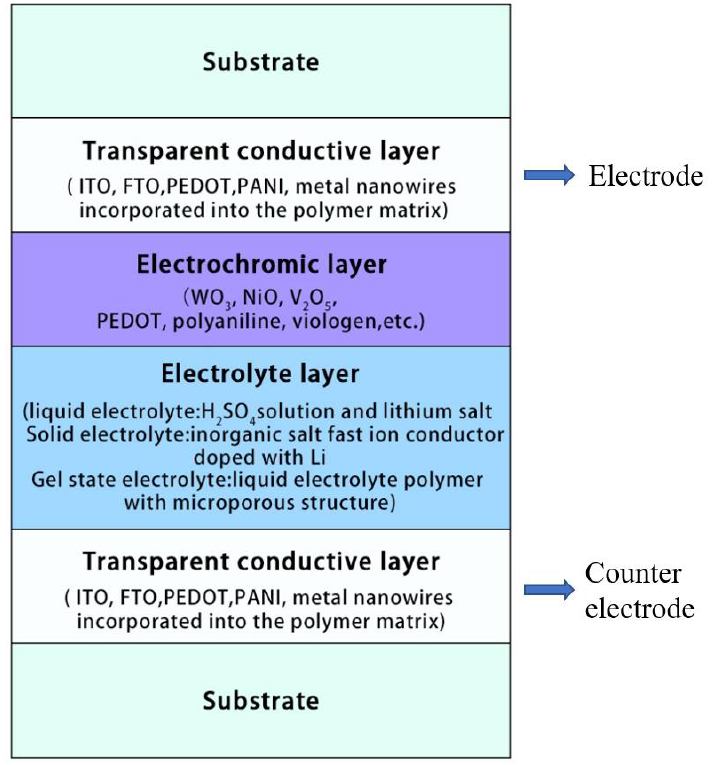
Figure 2. Configuration of a typical electrochromic device.